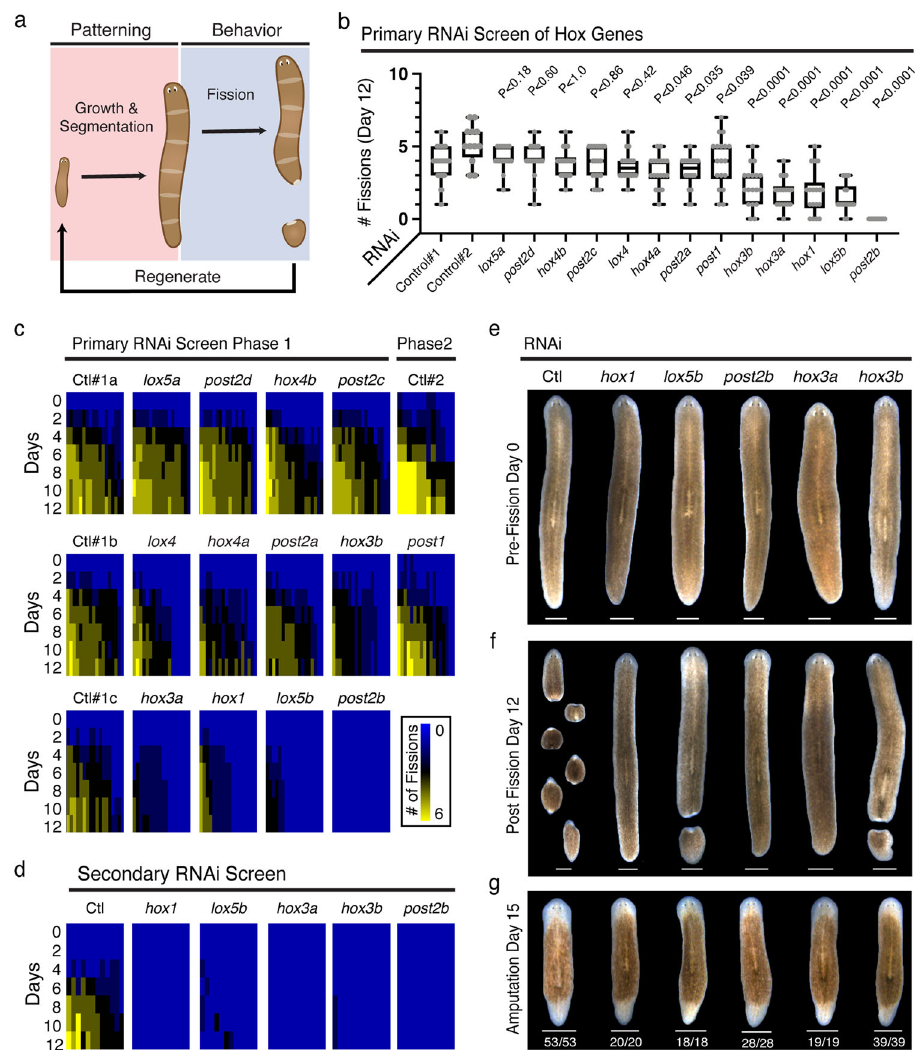
Fig. 1 Planarian Hox genes are required for adult asexual reproduction. a Diagram of the patterning and behavioral aspects of planarian asexual reproduction. b Fission activity following RNAi against Hox genes. Plot depicts fi ssion progeny number on day 12 of primary RNAi screen ( n = 54, 12, and 18 animals for Control#1, Control#2, and all other RNAi samples, respectively; p -value calculated by Welch ’ s two-tailed t -test versus corresponding control; Control#1 vs. lox5a , post2d , hox4b , post2c , lox4 , hox4a , post2a , hox3b , hox3a , hox1 , lox5b , post2b p -values = 0.1733, 0.5958, >0.9999, 0.8582, 0.4191, 0.0455, 0.0348, <0.0001, <0.0001, <0.0001, <0.0001, and <0.0001, respectively, Control#2 vs. post1 p -value = 0.0384). Box and whisker plot depicts individual data points, median (center), 25th/75th percentile (bounds of box), and minima/maxima (whiskers). Source data are provided as a Source Data fi le. c , d Heatmaps depicting fi ssion activity following RNAi treatment for both the ( c ) 2-phase primary and ( d ) secondary Hox RNAi screens. Cumulative fi ssions over time are displayed for individual worms from each RNAi condition ( n = 12 or 18 animals). Source data are provided as a Source Data fi le. e , f Representative images of animals from secondary Hox RNAi screen on days 0 and 12 of the fi ssion assay ( n = 12 animals, three independent repeats). Animals were given nine dsRNA feedings for primary phase I and 12 dsRNA feedings for phase II screening. Animals were given 17 bacterial RNAi feedings for secondary screening. g Representative images and phenotypic frequency of RNAi animals 15 days post-amputation after eight dsRNA feedings ( n = 18 – 53 animals, three independent repeats). Scale, 1